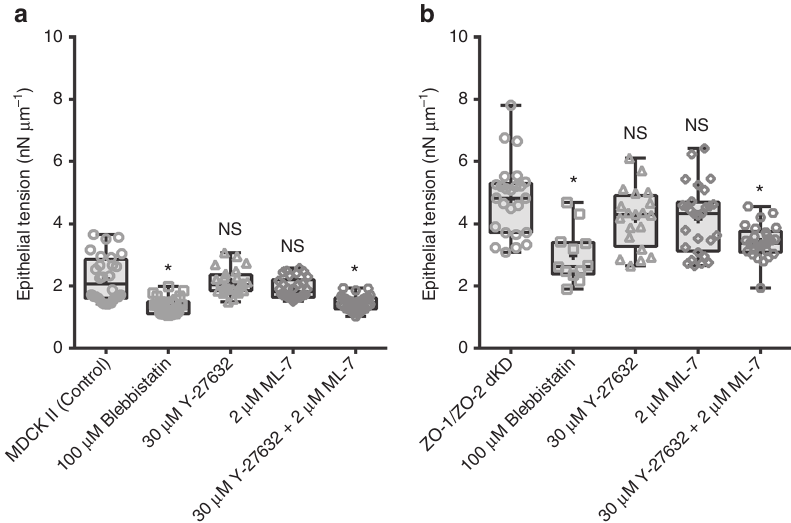
Fig. 4 Apical surface tension in polarized epithelium is mostly determined by myosin II motor ATPase activity rather than ROCK signaling or MLCK activity. Con fl uent monolayers of MDCK II controls and ZO-1/ZO-2 dKD cells were treated with 100 µ M blebbistatin, 30 µ M Y-27632, 2 µ M ML-7, or 30 µ M Y-27632+ 2 µ M ML-7 pharmacological drugs for 15 to 20 h. a Epithelial tension of MDCK II control untreated polarized monolayers, and treated either with 100 µ M blebbistatin, 30 µ M Y-27632, 2 µ M ML-7, or 30 µ M Y-27632+ 2 µ M ML-7. b Epithelial tension of MDCK II ZO-1/ZO-2 dKD untreated polarized monolayers, or treated either with 100 µ M blebbistatin, 30 µ M Y-27632, 2 µ M ML-7, or 30 µ M Y-27632+ 2 µ M ML-7. Myosin II activity inhibition signi fi cantly reduces the epithelial tension, whereas individual inhibition of ROCK signaling or MLCK activity do not cause a signi fi cant change on epithelial tension. Interestingly, combined inhibition of ROCK signaling and MLCK activity signi fi cantly reduces the epithelial tension. Data are represented as mean ± s.d.; * indicates signi fi cant difference in comparison with control P < 0.05 (unpaired two-tailed Student ’ s t -test with Welch ’ s correction); NS nonsigni fi cant differences in comparison with control P > 0.05(unpaired two-tailed Student ’ s t -test with Welch ’ s correction); number of measurements pooled for 2 – 3 independent experiments for each condition, n = 28, 27, 24, 30, and 29 for control, 100 µ M blebbistatin, 30 µ M Y-27632, 2 µ M ML-7, and 30 µ M Y-27632 + 2 µ M ML-7, respectively, and n = 25, 15, 20, 28, and 28 for ZO-1/ZO-2 dKD, 100 µ M blebbistatin, 30 µ M Y-27632, 2 µ M ML-7, and 30 µ M Y-27632+ 2 µ M ML-7,